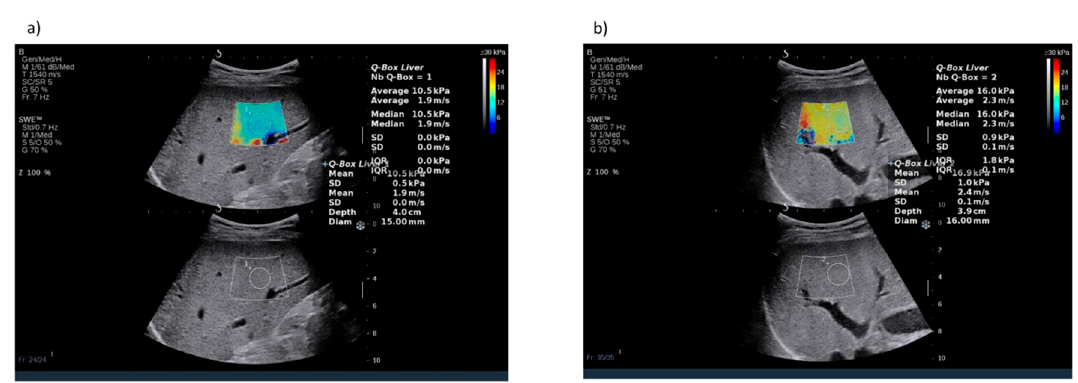
Figure 7. Examples of fibrosis assessment by shear wave elastography ( a ) in a patient with severe liver fibrosis (F3) ( b ) in a patient with cirrhosis (F4). Images courtesy of Dr. Maciej Janik and Prof. Piotr Milkiewicz from the Liver and Internal Medicine Unit, Medical University of Warsaw.